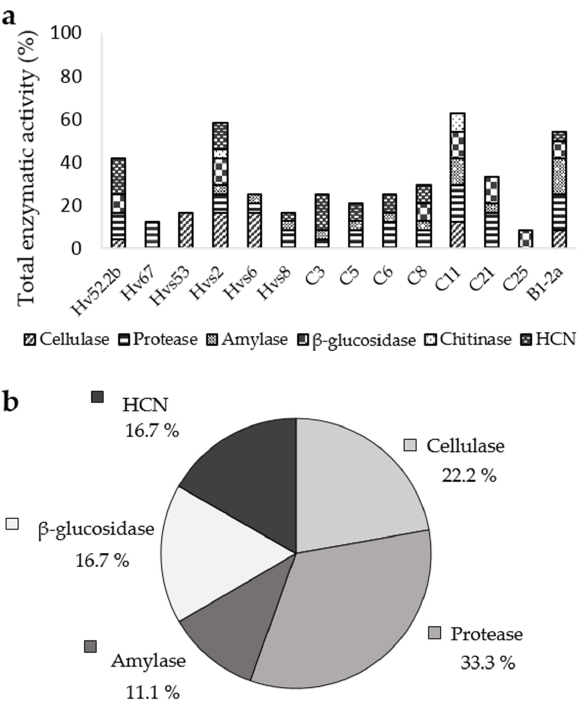
Figure 3. ( a ) Biocontrol enzymatic activity of the tested strains, expressed as a percentage with respect to the total enzymatic activities measured; ( b ) percentage of moderate and strong enzymatic activities obtained by all the tested strains. Results of Hvs2, Hvs6, and Hvs8 strains activities’ (less cellulase) were taken from the already published work of De la Lastra et al. [24].